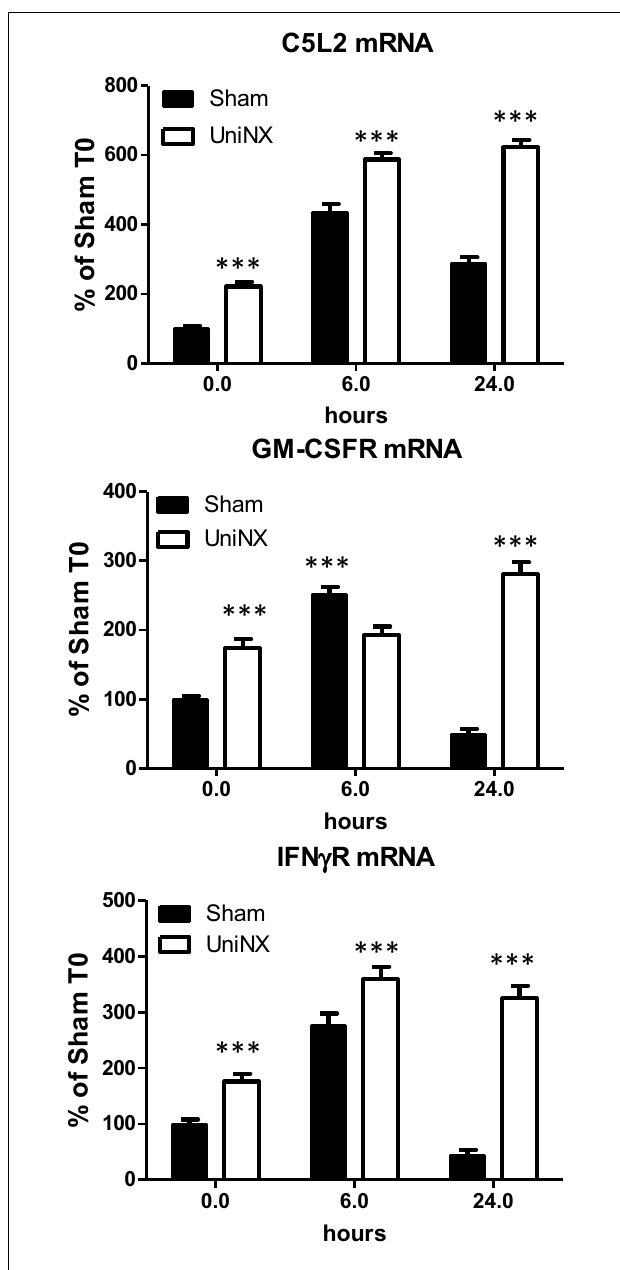
FIGURE 5 | Hypothalamic mRNA levels of receptors ASP (C5L2), GM-CSFR, and IFN γ R in Sham and UniNX animals after 6 and 24h after i.p. LPS injection . Values are means (cid:6) SE; n = 8/group. *** p < 0.001 corresponds to Sham vs.